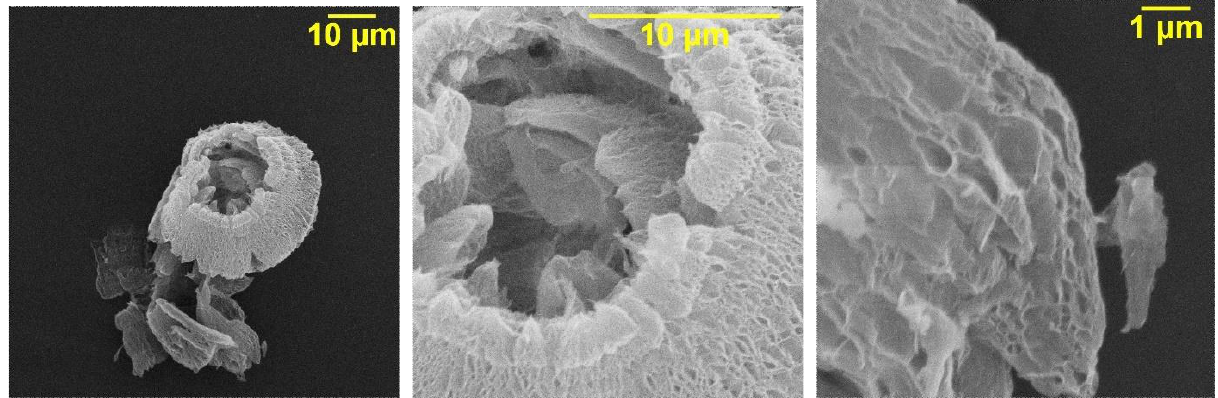
Figure 2. Scanning electron microscopy of thermally reduced graphene